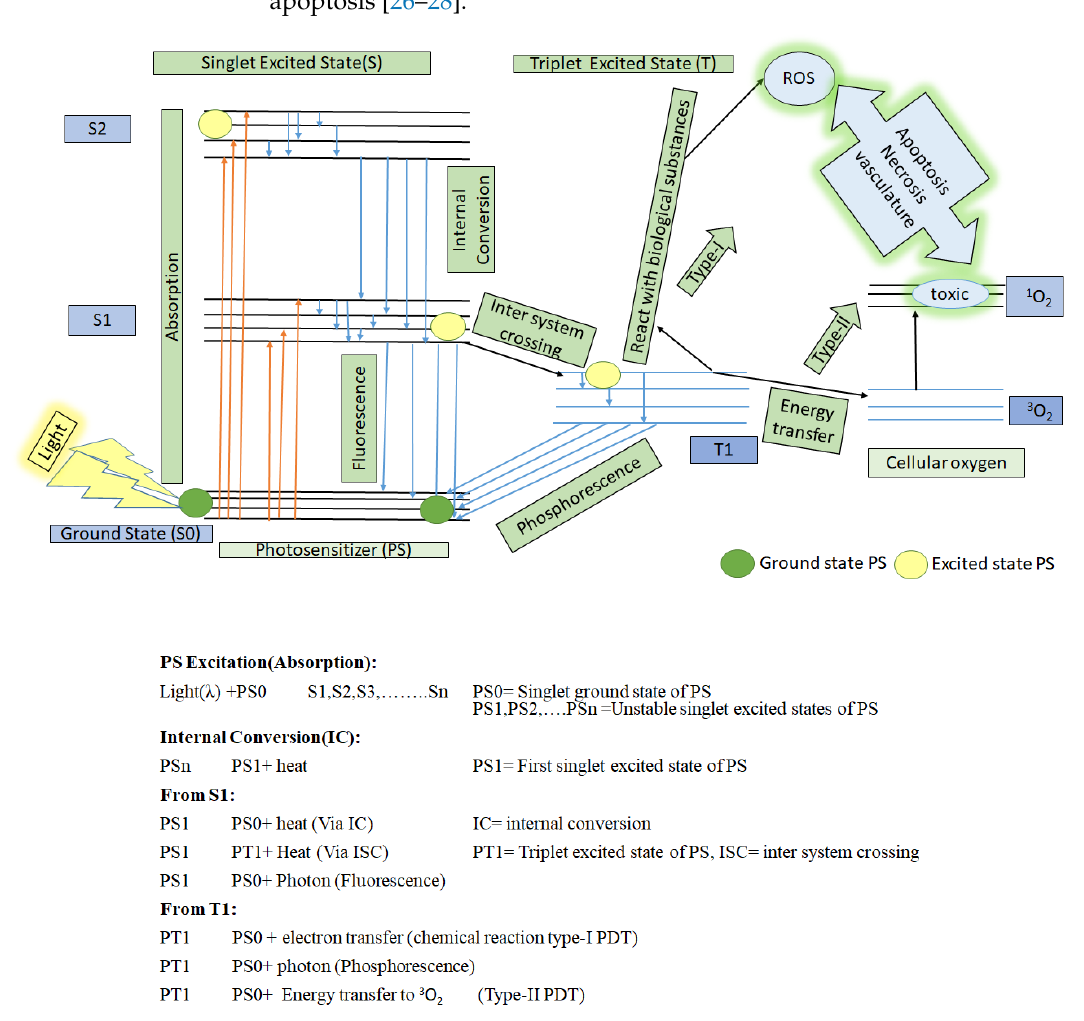
Figure 1. A schematic representation of photosensitization that includes type-I and type-II PDT on the basis of the Jablonski diagram. Redrawn from [4].